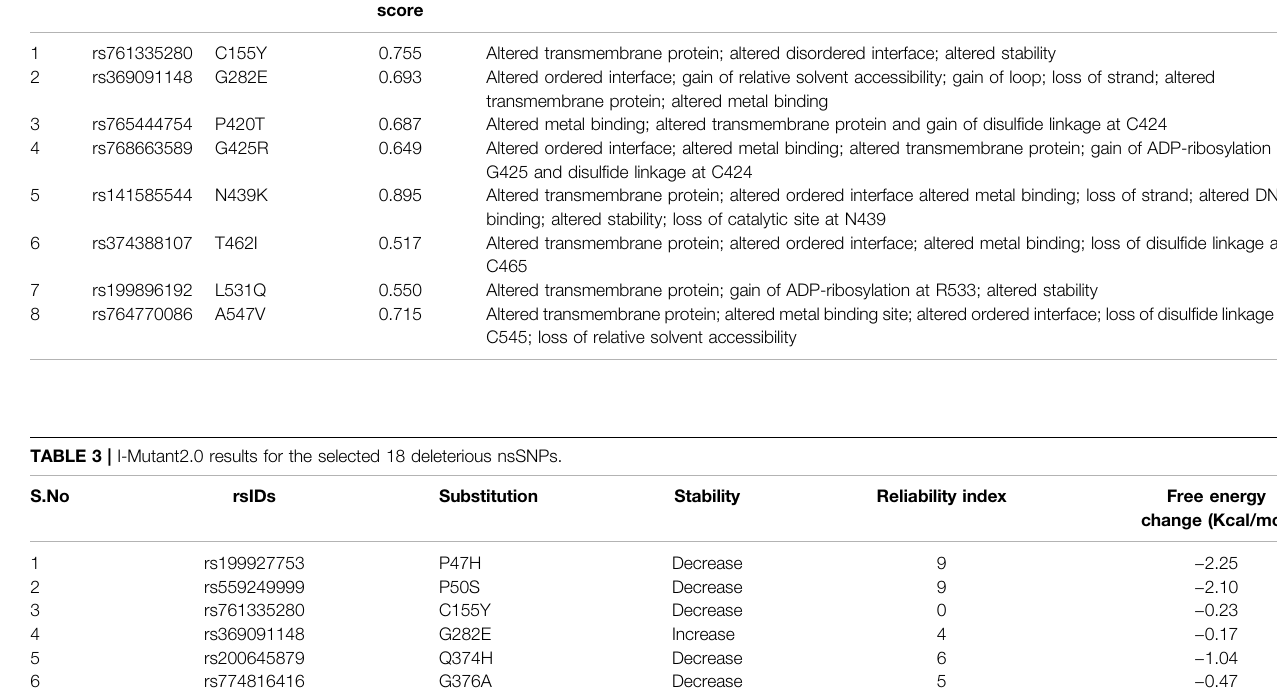
TABLE 2 | List of eight deleterious nsSNPs and the resulting structural and functional alterations in hZP2 protein, as predicted by MutPred2. S.No